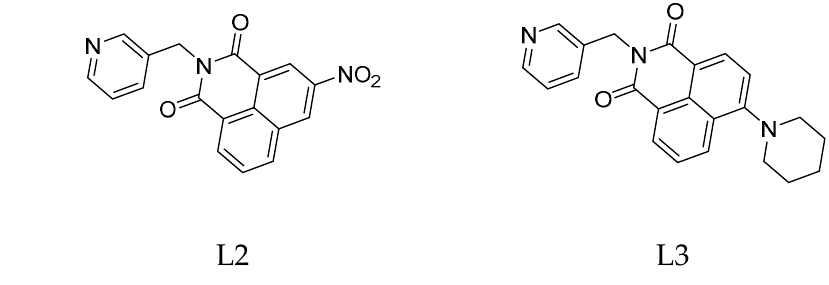
Figure 1. Structures of the ligands L1, L2, and L3.